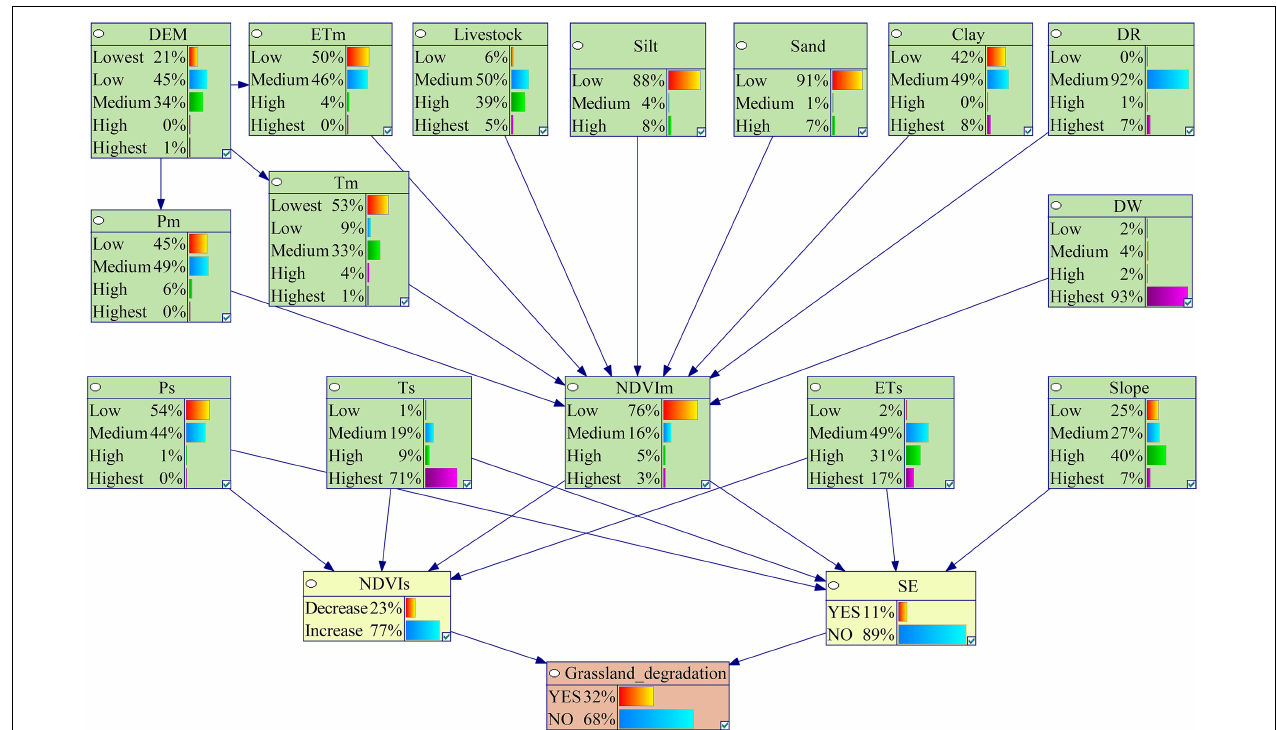
FIGURE 7 | Results of parameter learning in the BBN model. NDVIs, slope of NDVI change; SE, shrub-encroached grasslands.